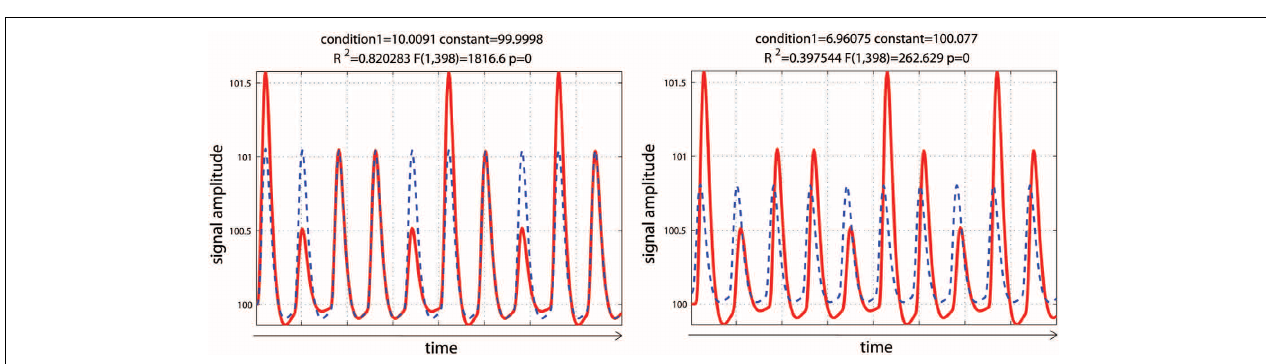
(model 1 only) in black. In model 1, condition 1 and 2 are modeled as positive effects relative to the constant term (7 . 5 + 1 . 5 = 9 for condition 1, 7 . 5 + 3 . 5 = 11 for condition 2) whereas for model 2 and 3, they are modeled as a negative effect relative to constant for condition 1 (10 – 1 = 9 for model 2 or 10 – 0.5 ∗ 2 = 9 for model 3) and a positive effect relative to constant for condition 2 (10 + 1 = 11 for model 2 and 10 + 0 . 5 ∗ 2 = 11 for model 3). Despite those differences, contrasts C between the conditions gave the same T -values.